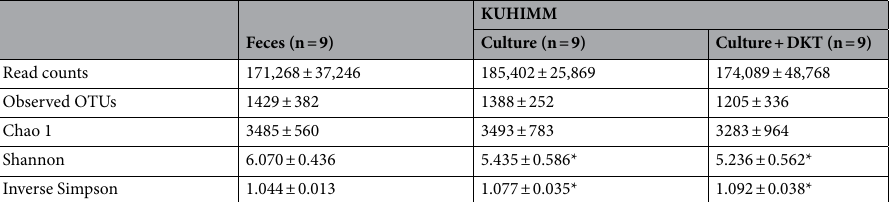
Table 1. Summary of bacterial 16S rRNA gene sequencing data and alpha diversity measures. The values show the mean ± standard deviation. The asterisks (*) indicate a significant difference (* P < 0.05 by Mann–Whitney’s U test) between the microbiota in original feces and corresponding KUHIMMs with and without daikenchuto (DKT). OTUs operational taxonomic